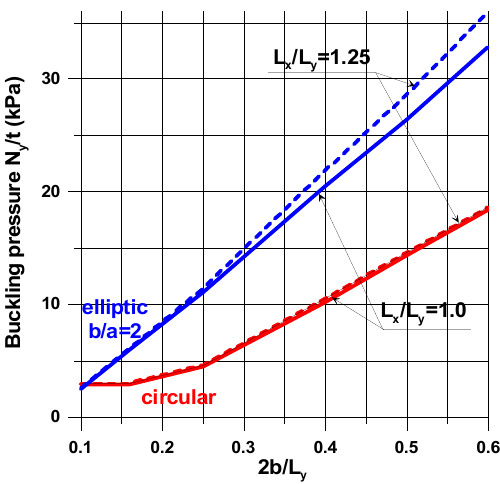
Figure 16. Variation in buckling loads with different geometrical parameters—isotropy E 1 / E 2 = 1, G 12 / E 1 = 0.015.